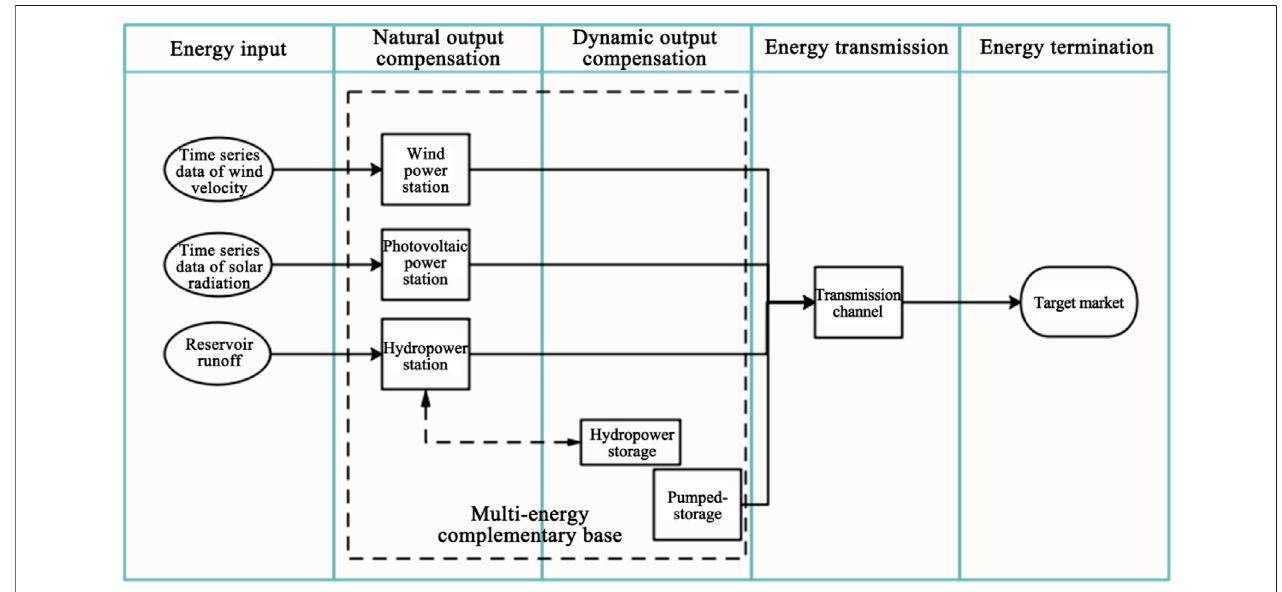
FIGURE 1 | System